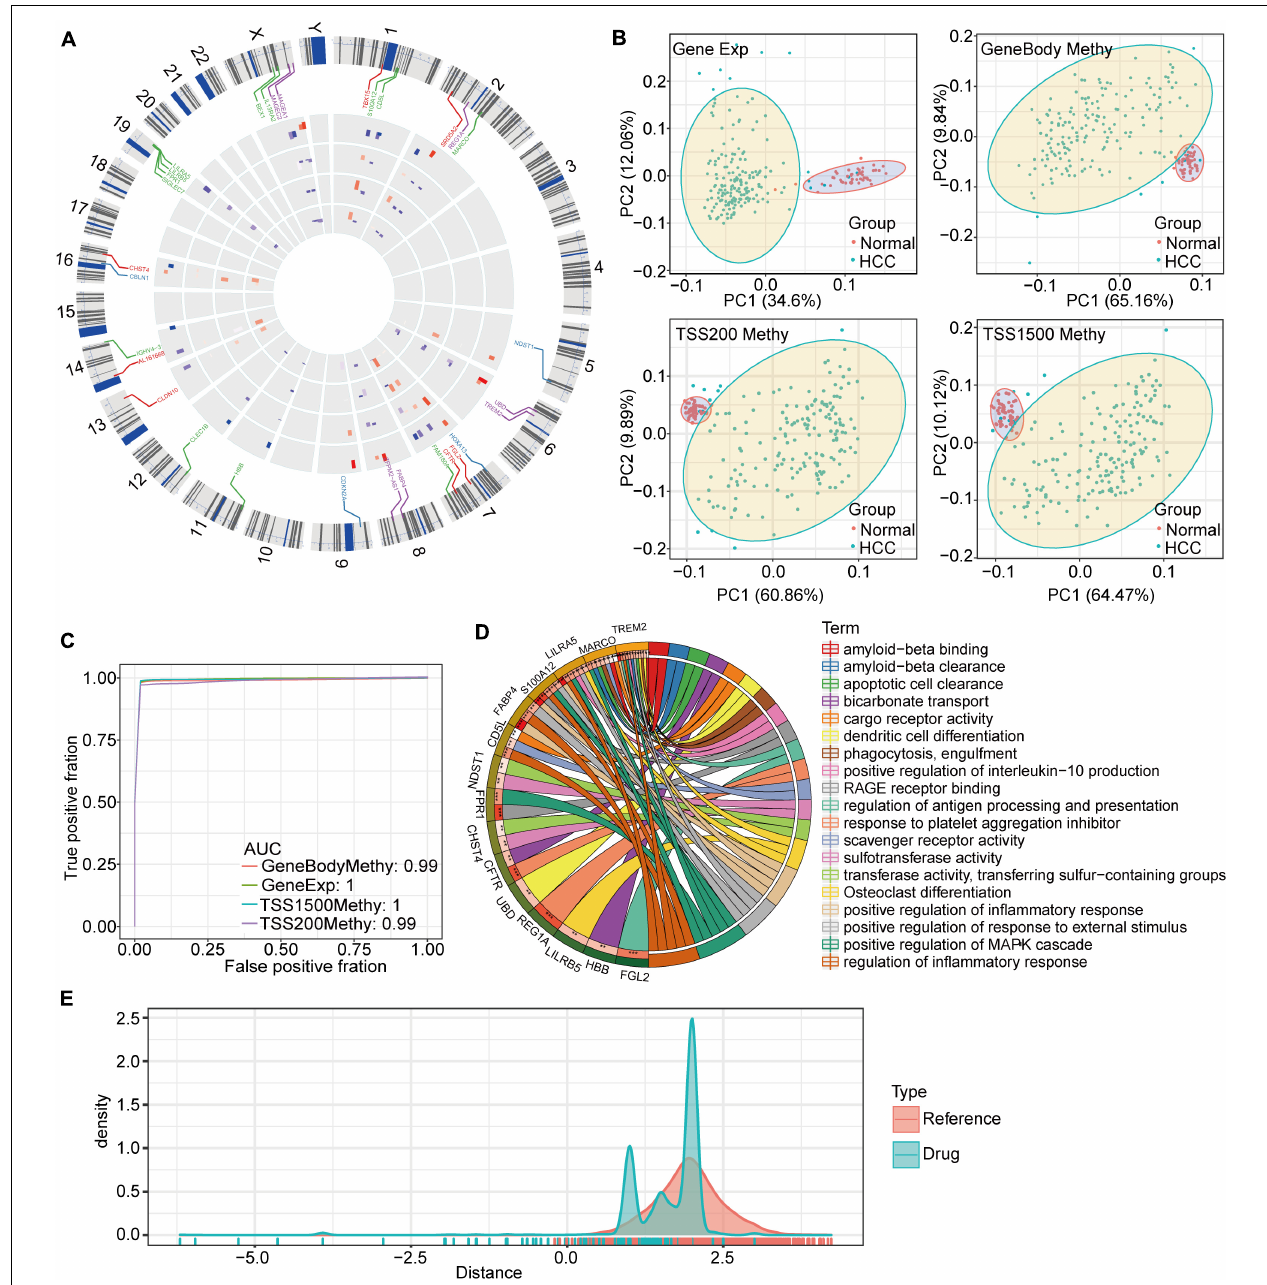
FIGURE 5 | Characteristics of DMEGs and drug distance. (A) DMEG distributions on chromosomes. (B) Principal component analysis of DMEG expression and methylation in the three DNA regions. (C) Construction of the linear discriminant model based on the expression profiles and methylation levels of DMEGs for predicting the ROC curves for HCC and normal samples. (D) The results of KEGG pathway-annotation and gene ontology enrichment analyses for the DMEGs, with different colors representing different pathways, and the lines indicating relationships between genes and pathways. (E) A drug distance-density plot for the differentially methylated and expressed gene